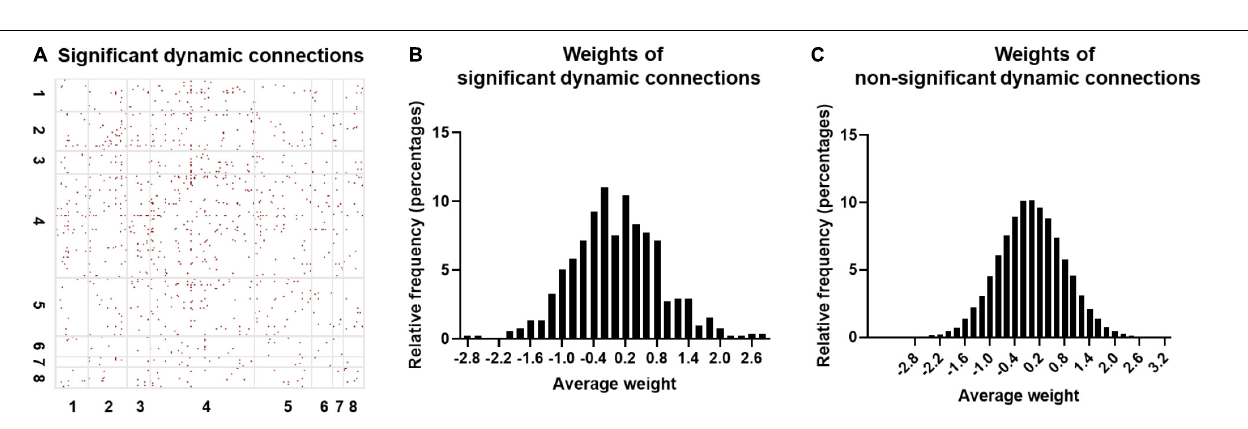
FIGURE 4 | Connectivity patterns with high task-related weights. (A) Distributions of functional connections with feature weights that are larger than the threshold for three prediction tasks. Different brain functional networks are represented by segments of different colors, and the length of the segment refers to the total number of connections. Ribbons refer to functional connections, and the width of ribbon refers to the number of intra-network and inter-network connections. (B) Average feature weights of intra-network and inter-network connections for three tasks.